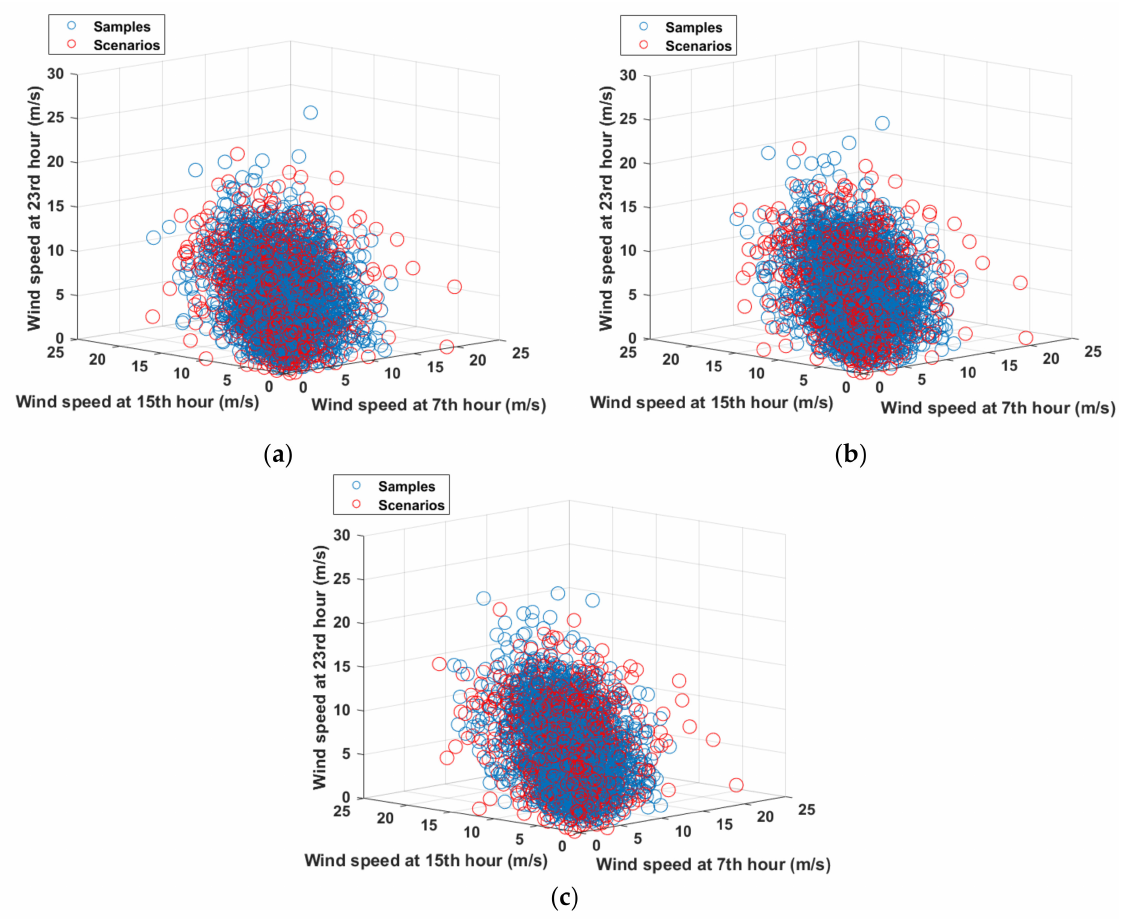
Figure 7. Wind speed samples and scenarios at the 7th, 15th, and 23rd hours ( a ) for WF 1, ( b ) for WF 2, ( c ) for WF